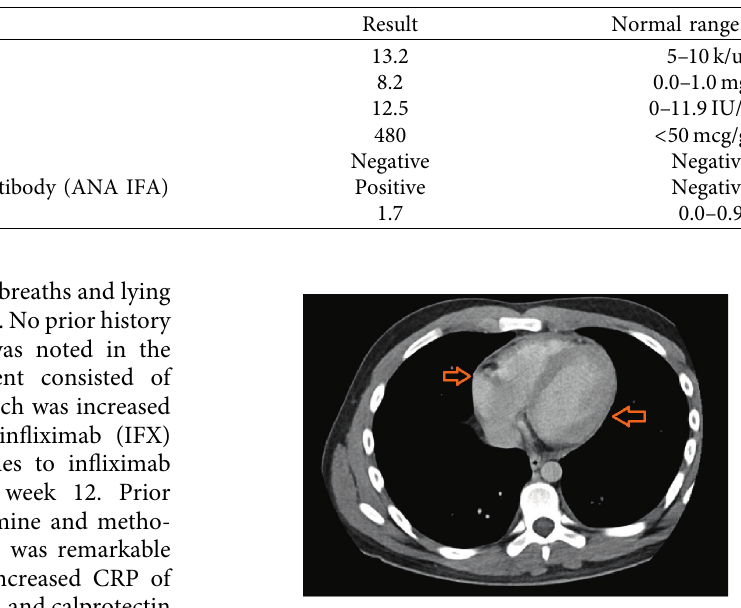
Figure 1: Computed tomography (CT) of the chest demonstrating pericardial thickening.